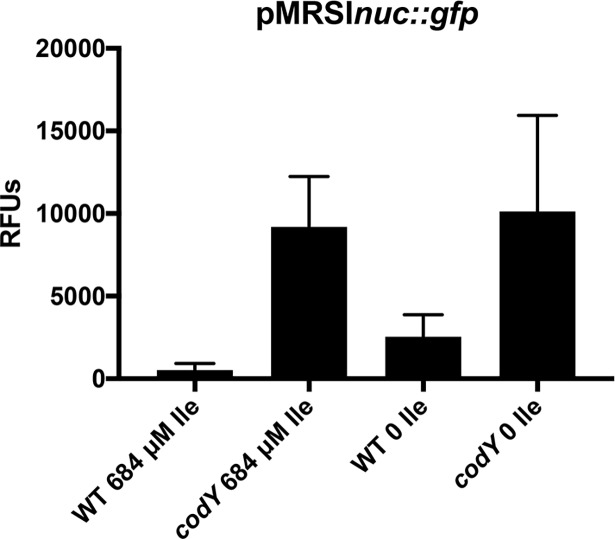
Isoleucine limitation induces nuc expression.Strains were pre-grown in complete CDM to exponential phase and then sub-cultured into either complete CDM or CDM lacking Ile, as indicated. Fluorescence values were read when cells achieved mid-exponential phase and were normalized to OD600nm. Data are the mean of three biological replicates +/- SEM.